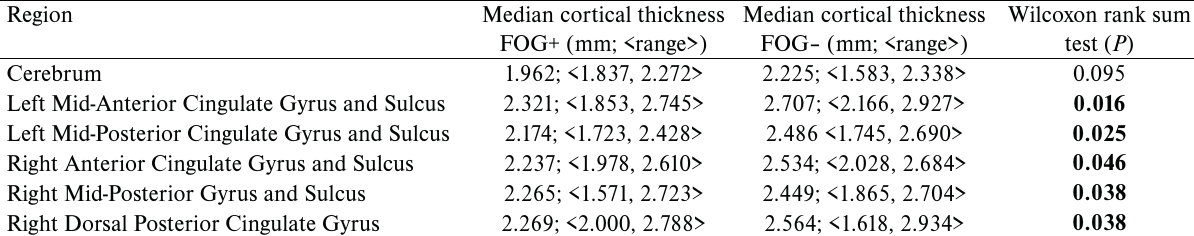
Table 3. Differences in global and regional cortical thickness.